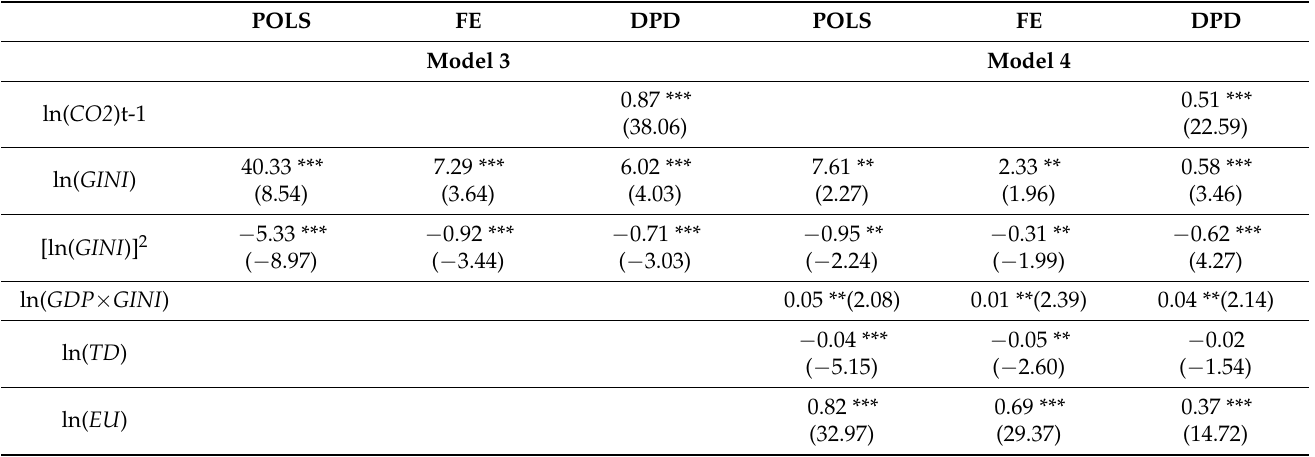
Table 5. The effect of income inequality (measured by Gini coefficient) on CO 2